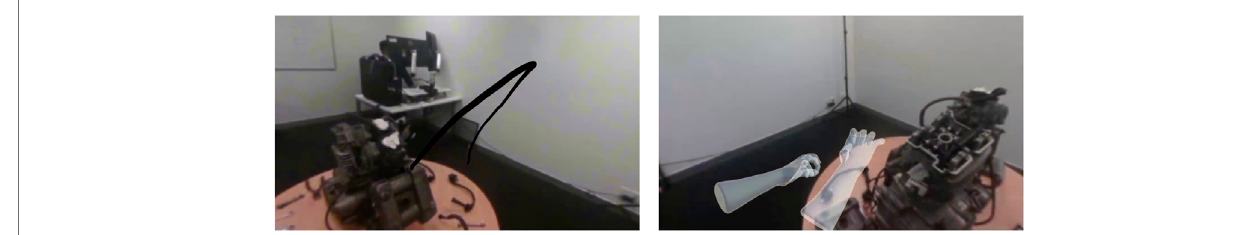
FIGURE 3 | (A) Annotation and (B) Hand Gesture from the user ’ s perspective.